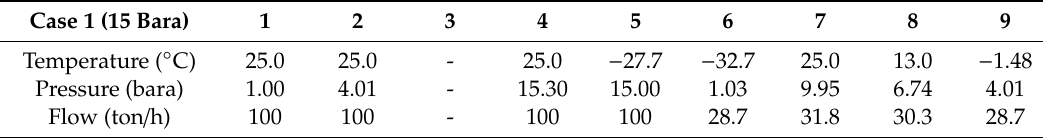
Table A6. Mass balance Case 2, 15 bara liquefaction pressure, stream numbering from Figure 1.